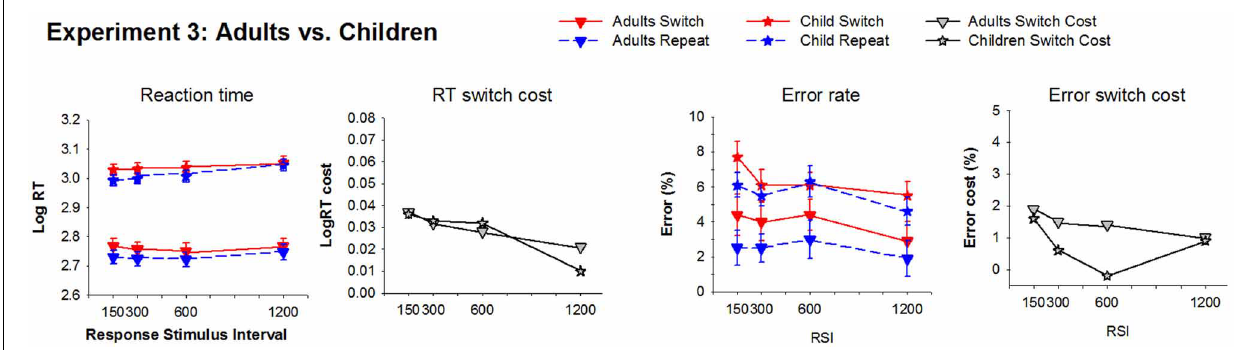
FIGURE 6 | Average reaction time and error rate for switch and repeat trials and their switch cost at each RSI condition for Experiment 3. Downward triangle: Adults; Star: